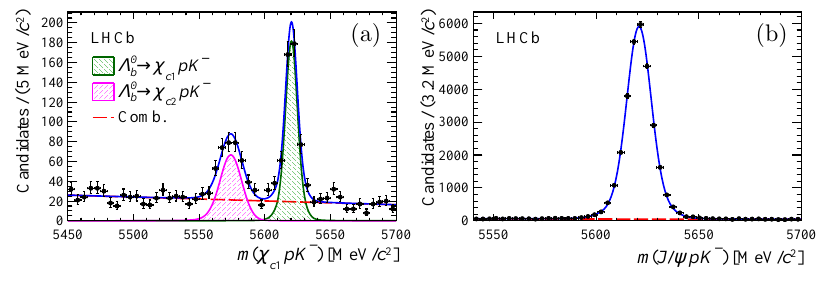
→ J /ψ pK − invariant mass distributions. Data points are shown Figure 2. Fits to the (a) Λ b → χ c 1 pK − and (b) Λ 0 b in black and the results of the fits are shown as solid blue lines. The components are the Λ b → χ c 1 , c 2 pK − signal and combinatorial background (Comb.). The Λ b → χ c 1 pK − component is shifted and broadened by the use of a χ c 1 mass constraint in the analysis. The figure is taken from Ref.